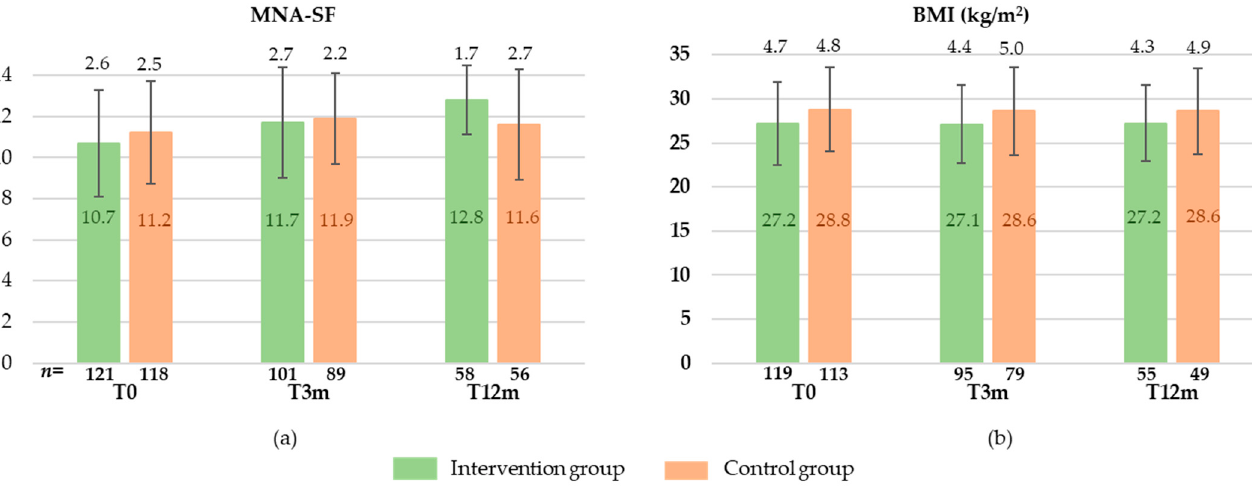
Figure 2. MNA-SF (Mini Nutritional Assessment-Short Form) ( a ) and BMI (Body Mass Index) ( b ) at baseline (T0), after 3 months (T3m), and after 12 months (T12m) in intervention and control group (means ± standard deviation).